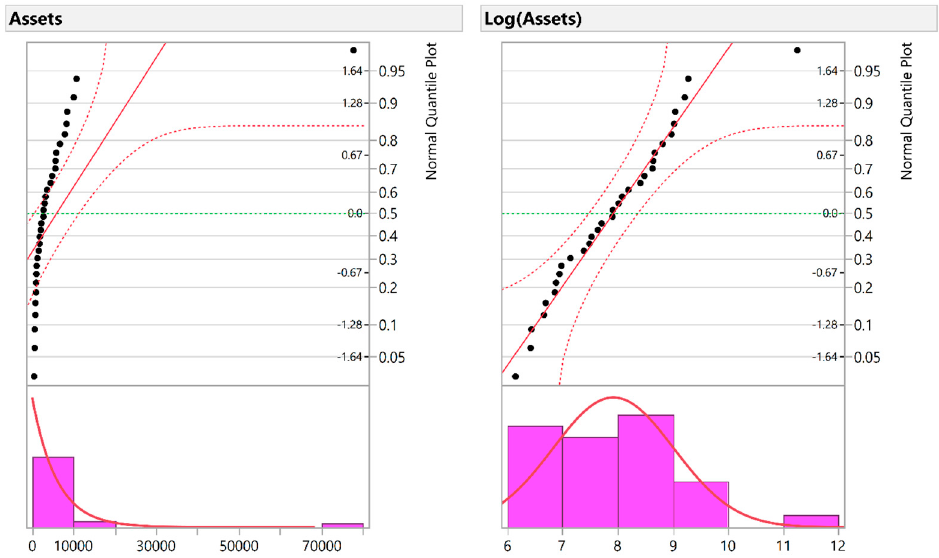
Figure 7. The normal Q–Q plots (up) for the Assets variable before and after transformation and the frequency histogram of the Assets on the left (down) fitted to an exponential distribution (red).